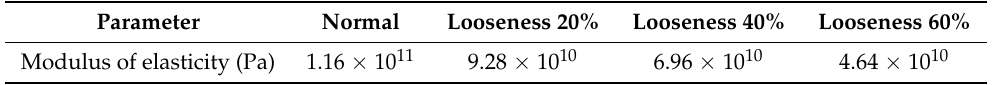
Figure 5. Model of the winding looseness fault. ( a ) Normal; and ( b ) loose. Table 3. Parameter table of loose winding materials.